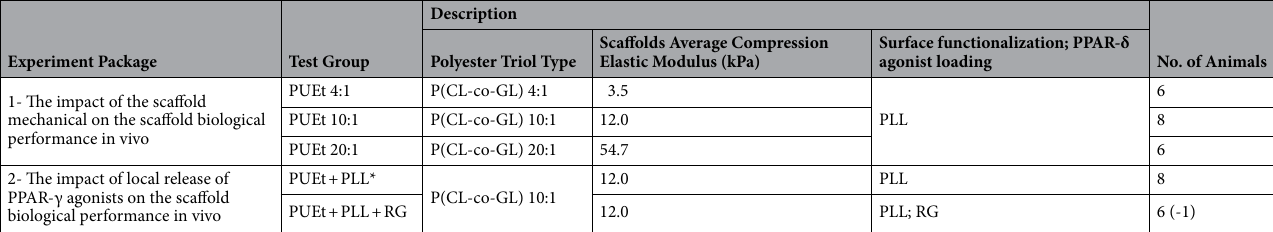
Table 5. The experimental design of the in vivo tests. *The test group: PUEt 10:1 + PLL, belonging to the first experimental package was used as control group for the second experimental package.